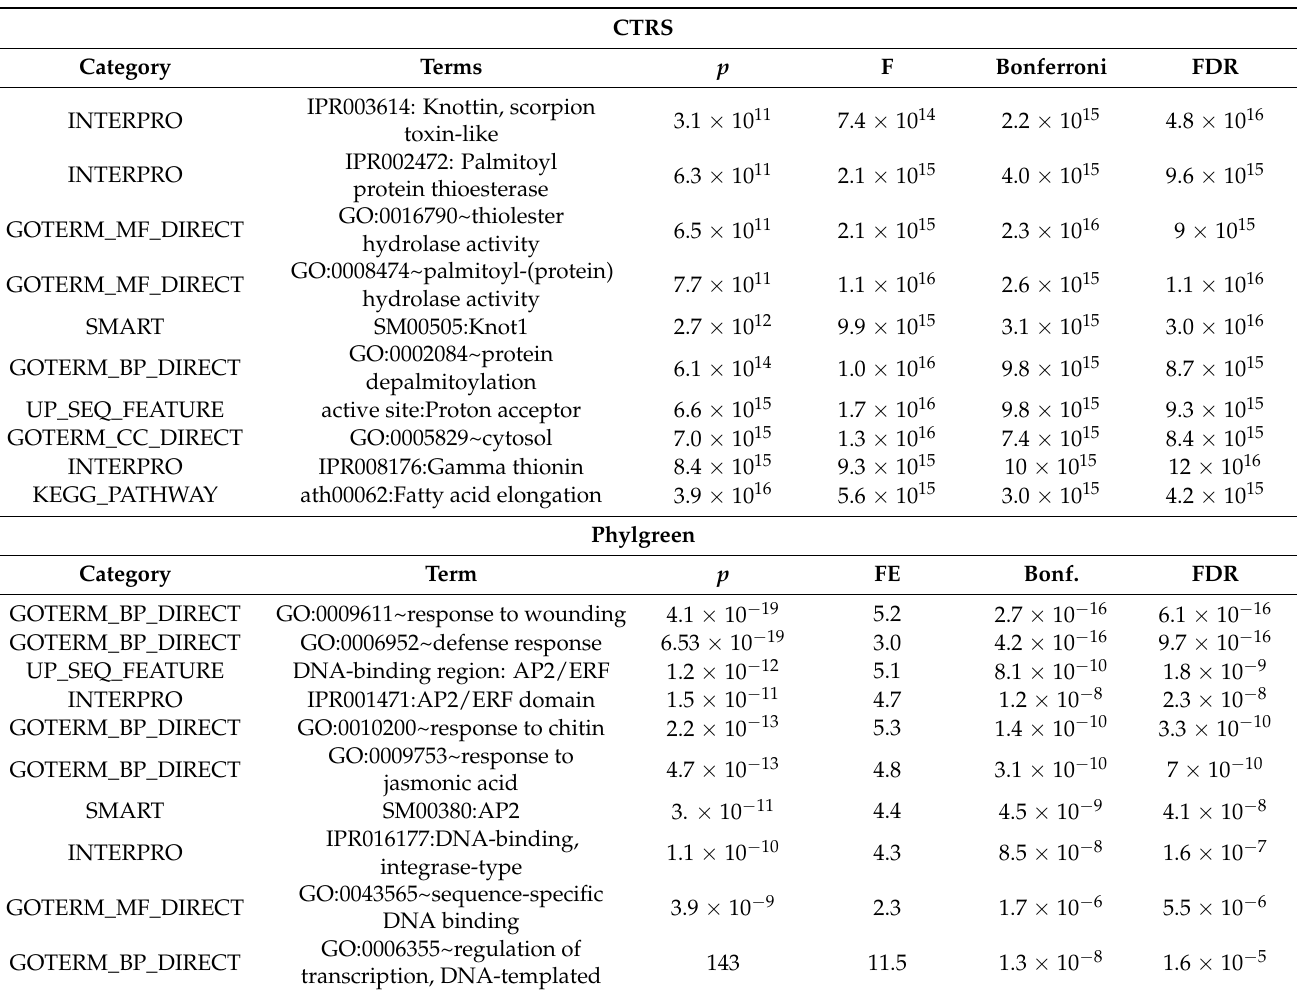
Table 2. DAVID functional analysis: functional annotation chart (FACH) of differentially expressed genes in CTRS, Phylgreen, and Delfan Plus (FC > 2) recognized in DAVID database. Functional category, terms, p value, fold enrichment, and statistical significance (Bonferroni, Benjamini, and FDR). Top ten (if available) genes in each